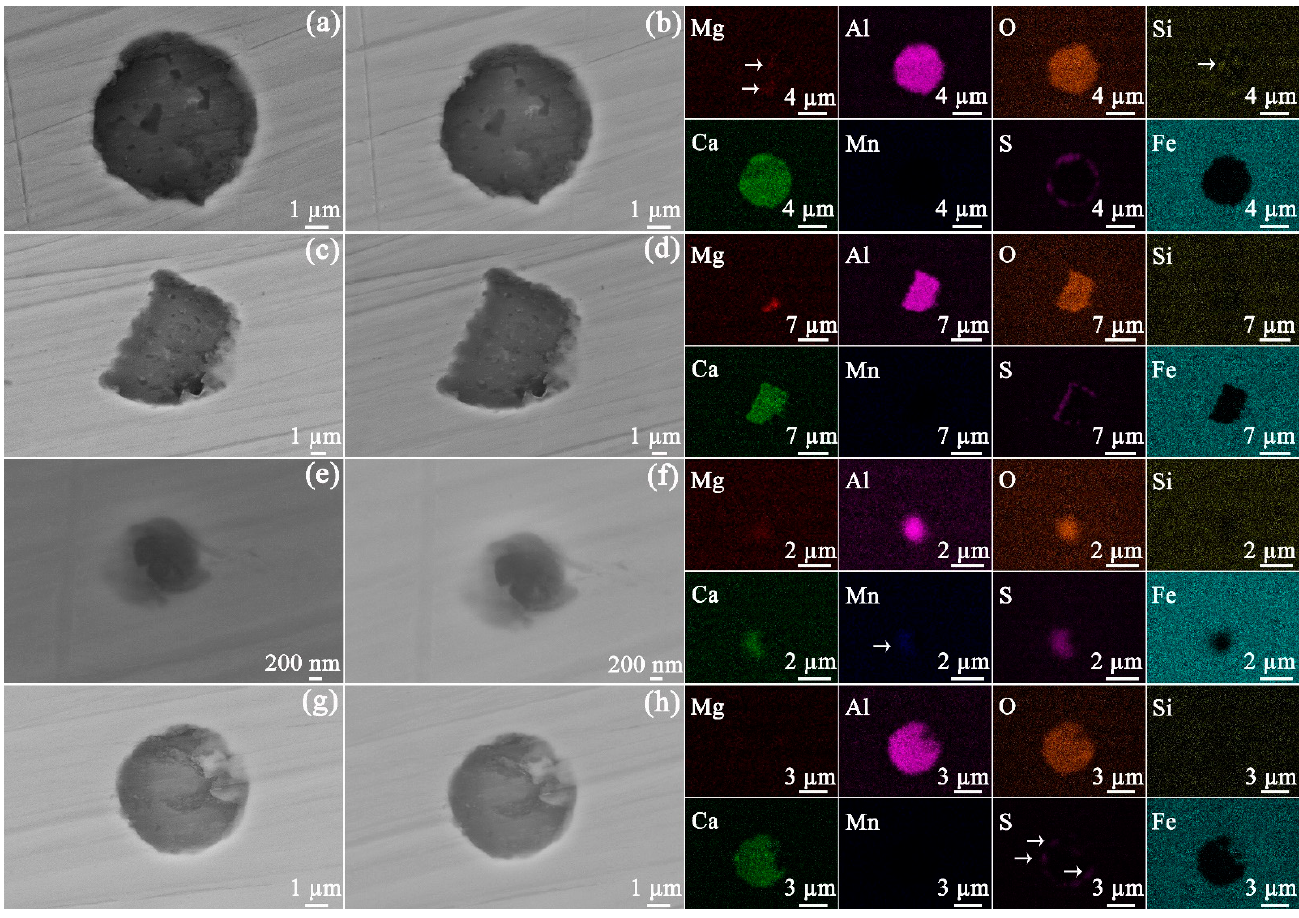
Figure 3. SEM SE images of the inclusion containing Mg − Al − Si − O − Ca − S before ( a ) and after ( b ) exposure to bitumen at 60 °C, of the inclusion containing Mg − Al − O − Ca − S before ( c ) and after ( d ) exposure to bitumen at 60 °C, of the inclusion containing Mg − Al − O − Ca − Mn − S before ( e ) and after ( f ) exposure to bitumen at 60 °C, and of the inclusion containing Al − O − Ca − S before ( g ) and after ( h ) exposure to bitumen at 60 °C. The elemental distributions of the inclusions are given at right. In the EDS maps given at right, the areas with low signal intensity are marked with arrows.